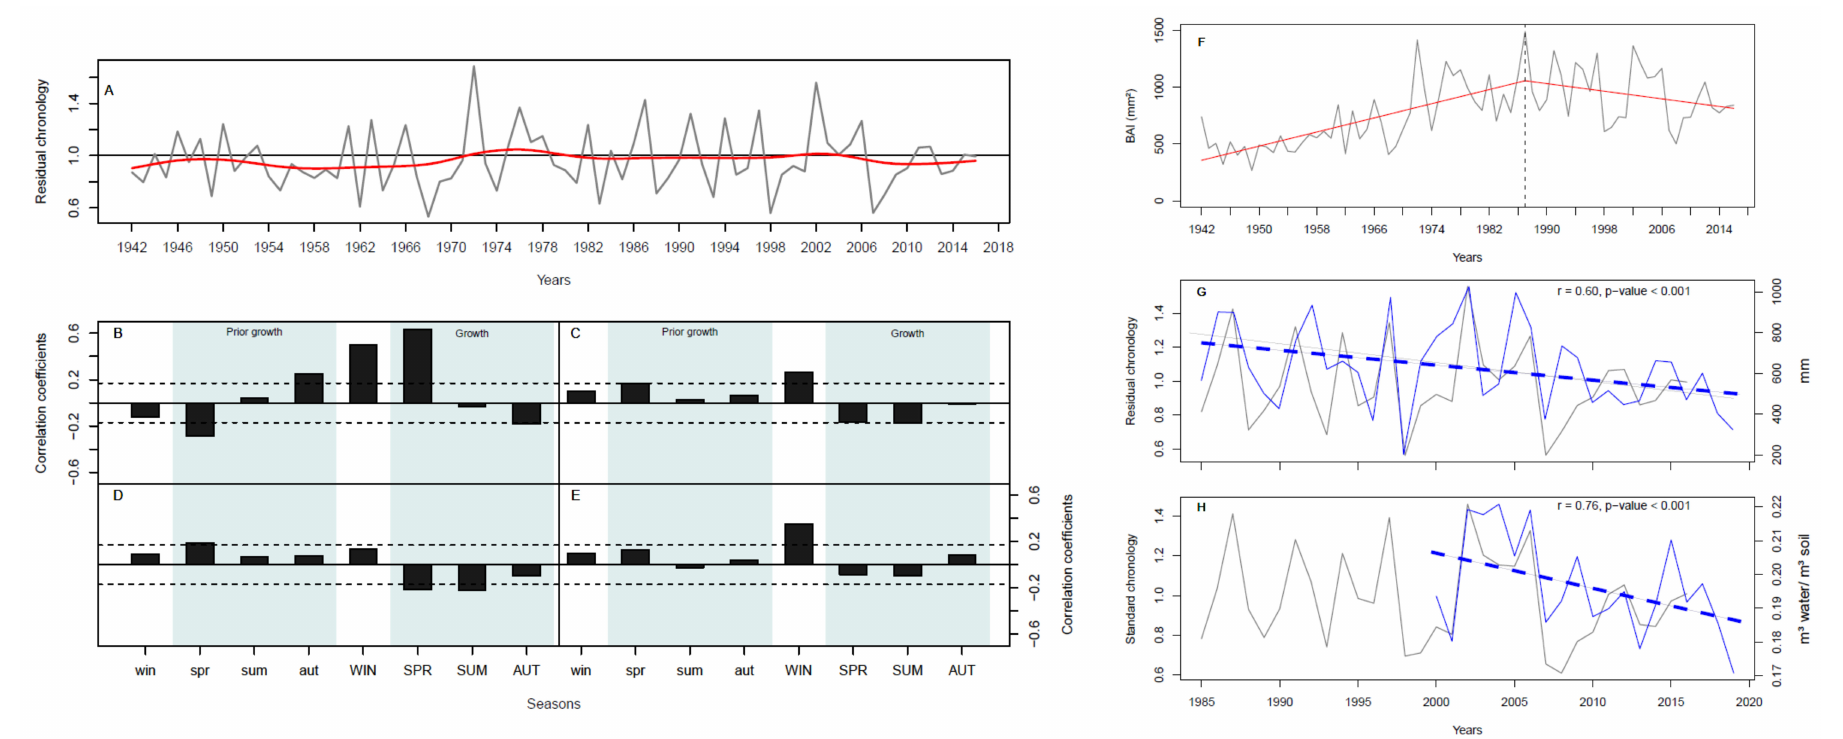
Figure 2. ( A ) Residual chronology of Nothofagus alessandrii (gray curve) with a smoothed filter of 20 years (red curve) and the number of trees per year (gray background) for the period of 1942–2016 (EPS > 0.85, with 10 trees). ( B – E ) Correlation coefficients between residual chronology ( A ) and local climatic variables: precipitation ( B ), mean temperature ( C ), and maximum ( D ) and minimum I. On the abscissa axis, the lower-case (upper-case) letters represent the seasons of the year: winter (win), spring (spr), summer (sum), and autumn (aut), and the shaded area (light blue) represents the previous (t − 1) and current (t) growing seasons. The segmented lines indicate a significant correlation coefficient ( p < 0.05) with a 95% confidence interval. ( F ) Average basal area increment series (BAI) and linear trends with detected breakpoint in 1985. ( G , H ) Correlations between the tree-ring chronology and precipitation (May to November) and surface soil moisture (September to November) for the period with significant negative decreasing trends